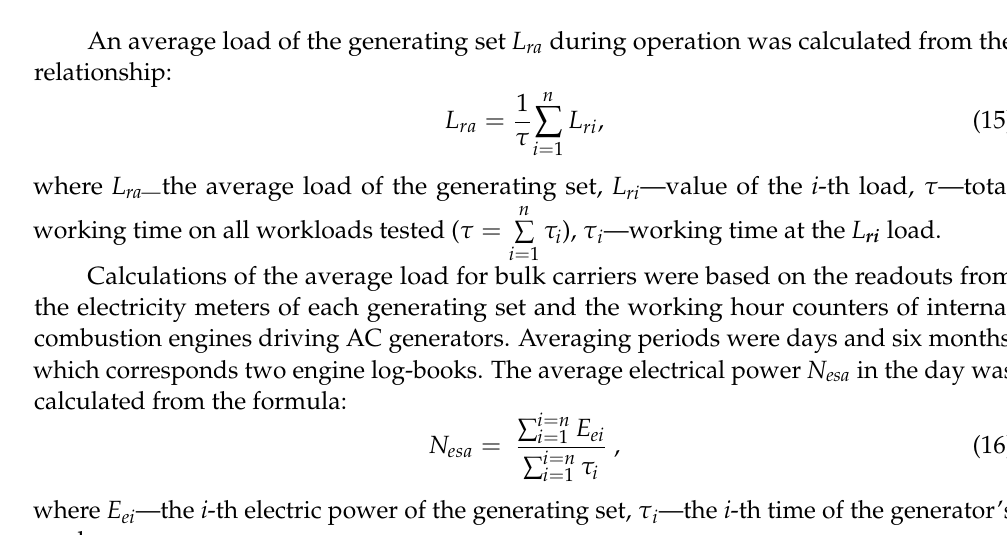
Figure 7. Systematized recorded load scenarios during exemplary tests on a seagoing ship ( a ) and time waveforms of pressure fluctuations of in the cylinder of an internal combustion engine in dynamic time as a result of load changes ( b ).